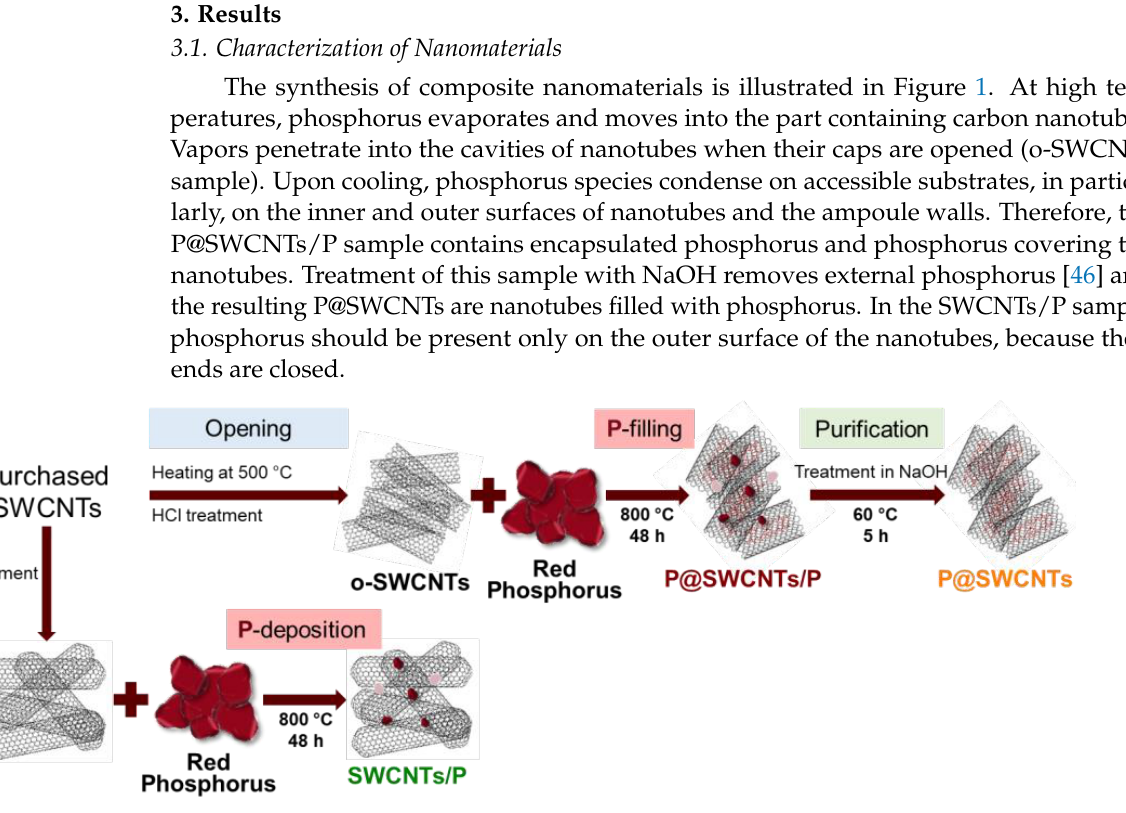
Figure 1. Schematic illustration of the synthesis of composite nanomaterials from SWCNTs and red phosphorus.